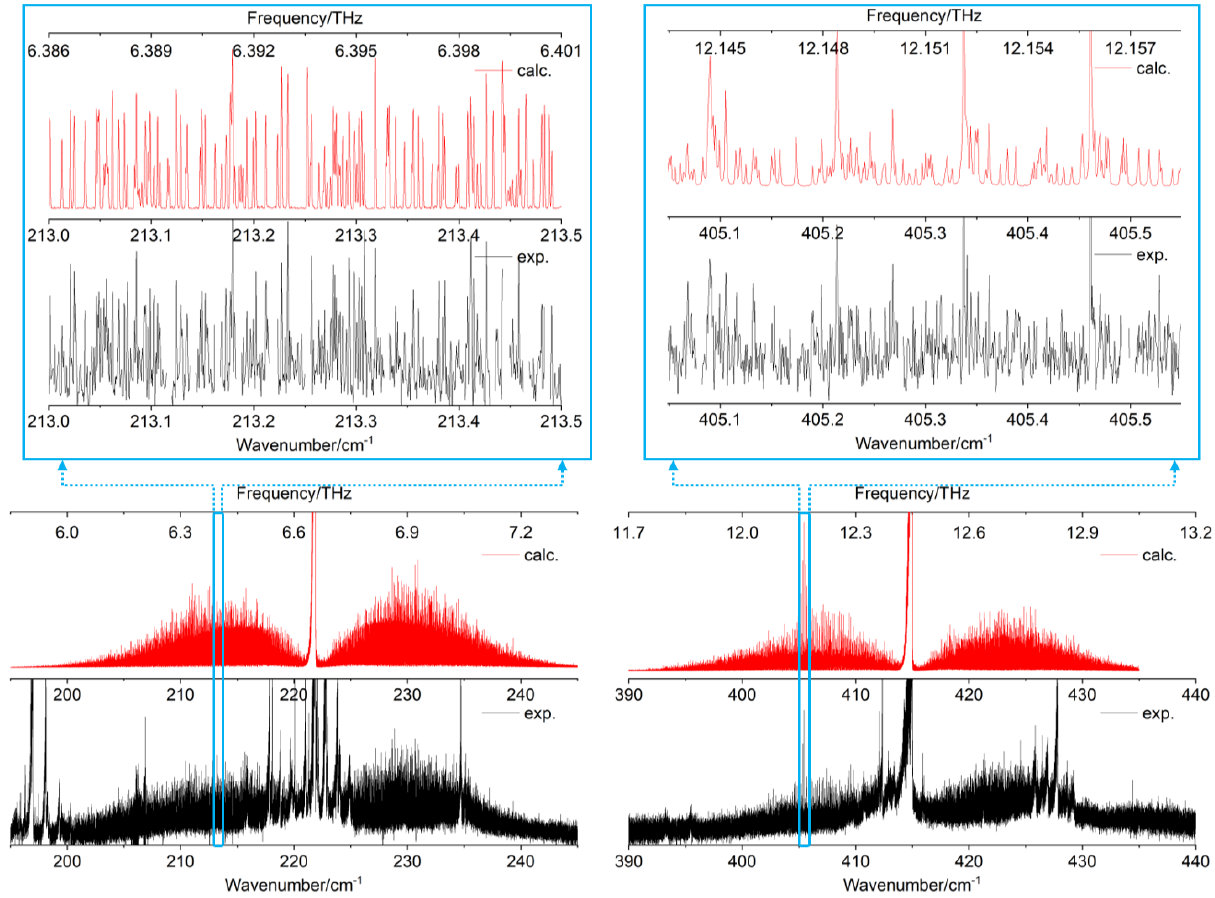
Figure 5. Left : rovibrational band of the ν 35 free -OH torsional mode. Right : rovibrational band of the ν 33 bonded -OH torsional mode. Experimental synchrotron-based FT-far-IR spectra are shown in black. Simulated spectra with the fitted constants of Table 4 are presented in red. Two zoomed parts highlight the quality of the rovibrational fit in the P-branches of the two fundamental